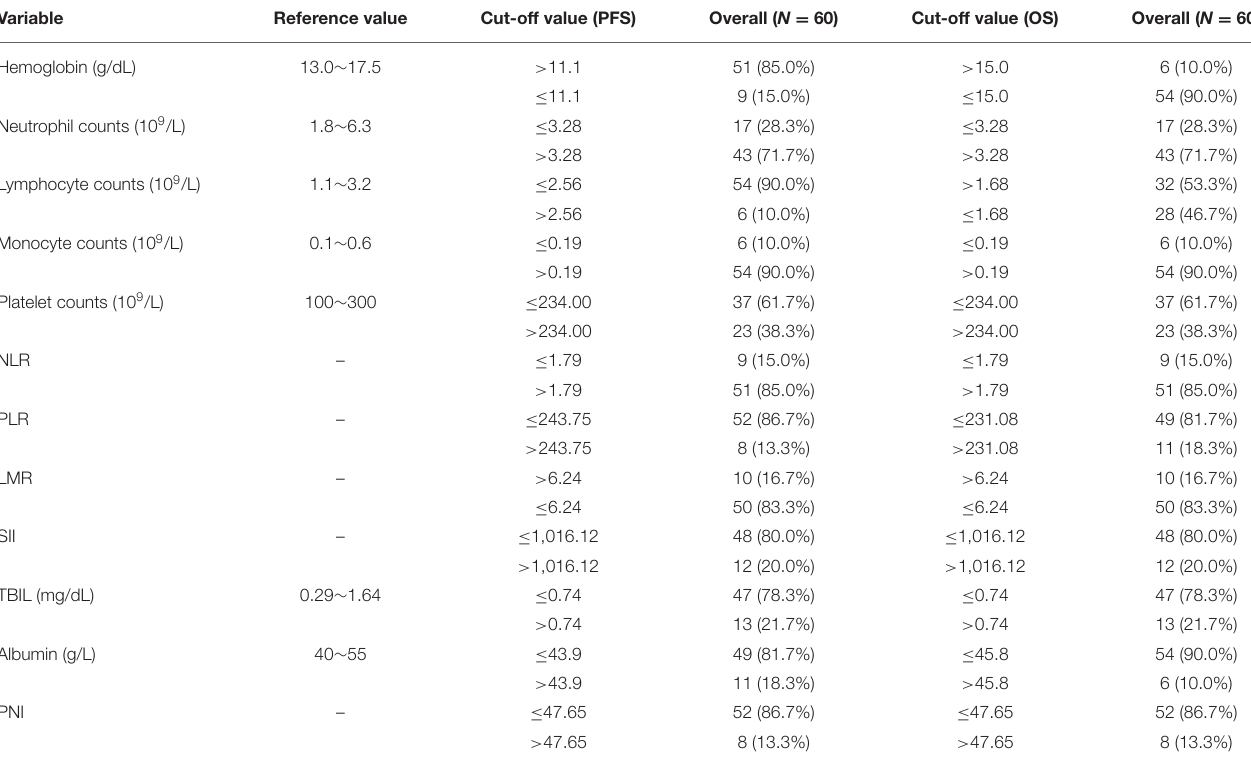
TABLE 2 | Cut-off values for PFS and